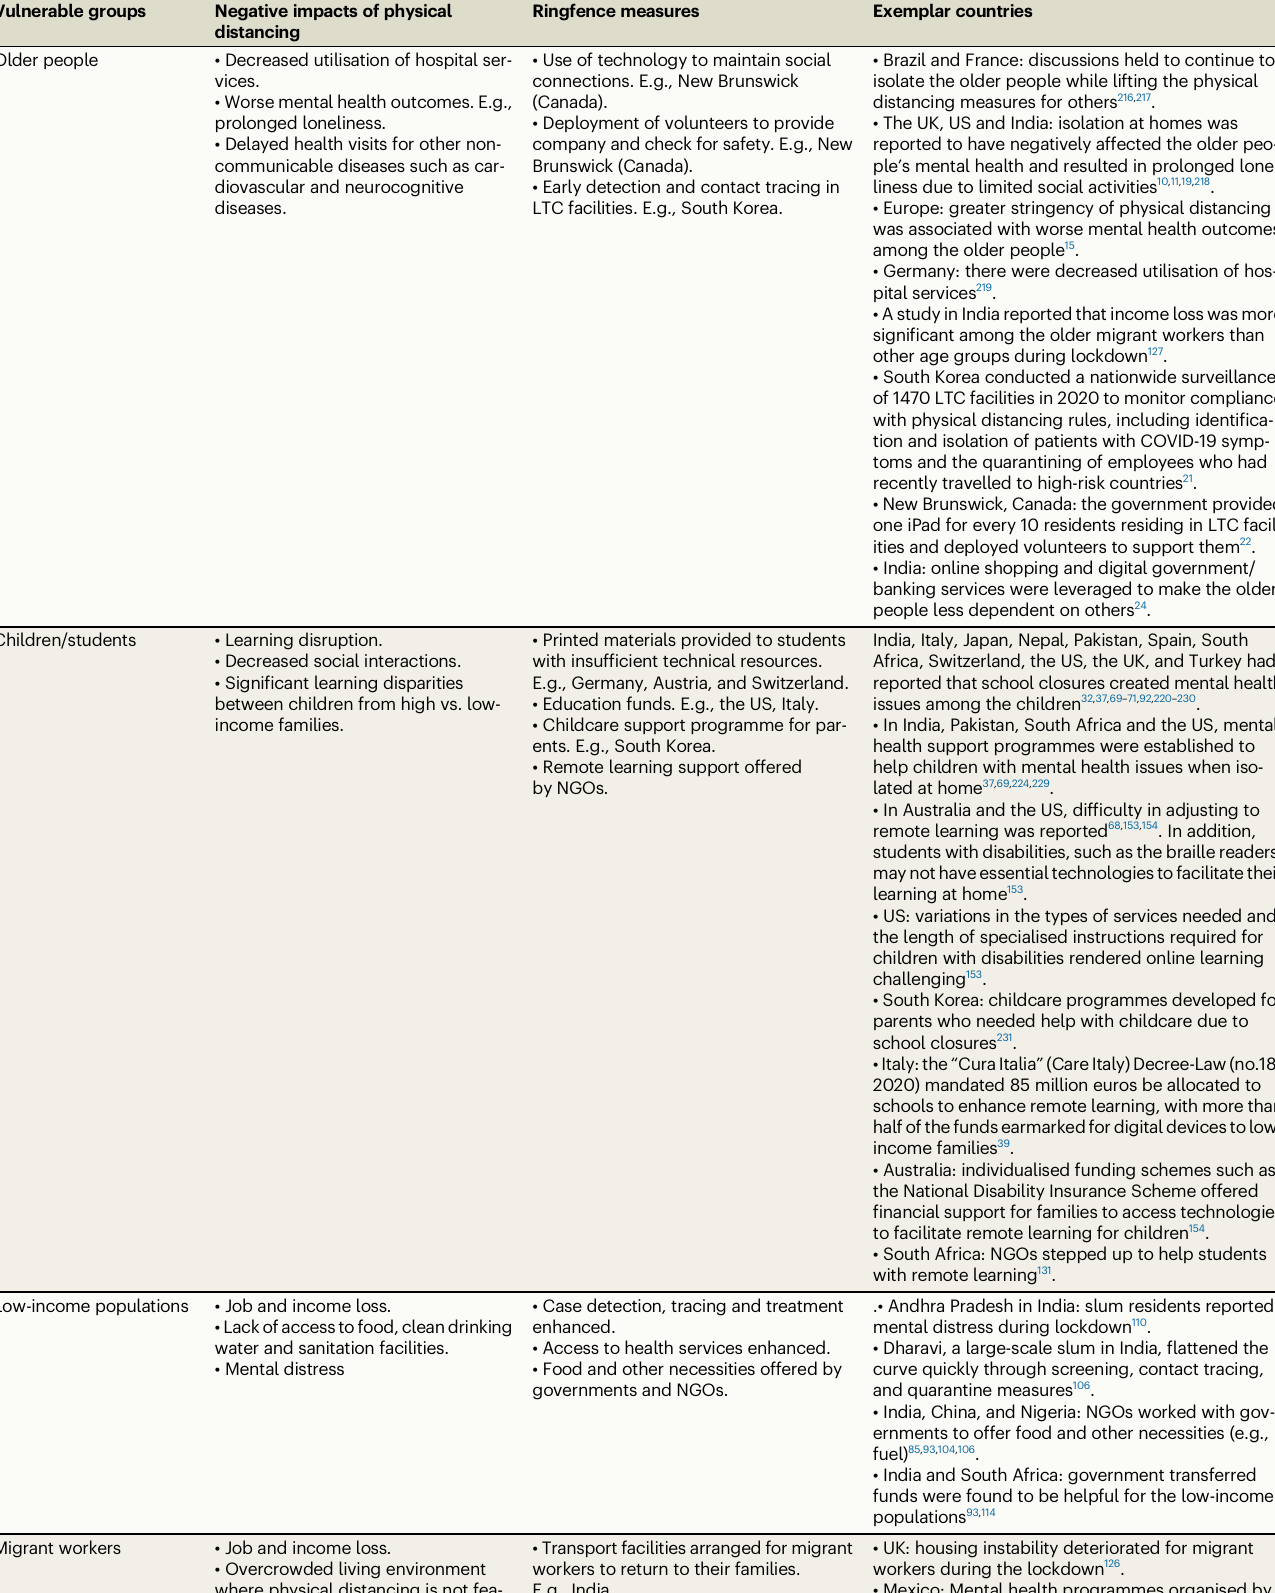
Table 1 | Summary of fi ndings across vulnerable